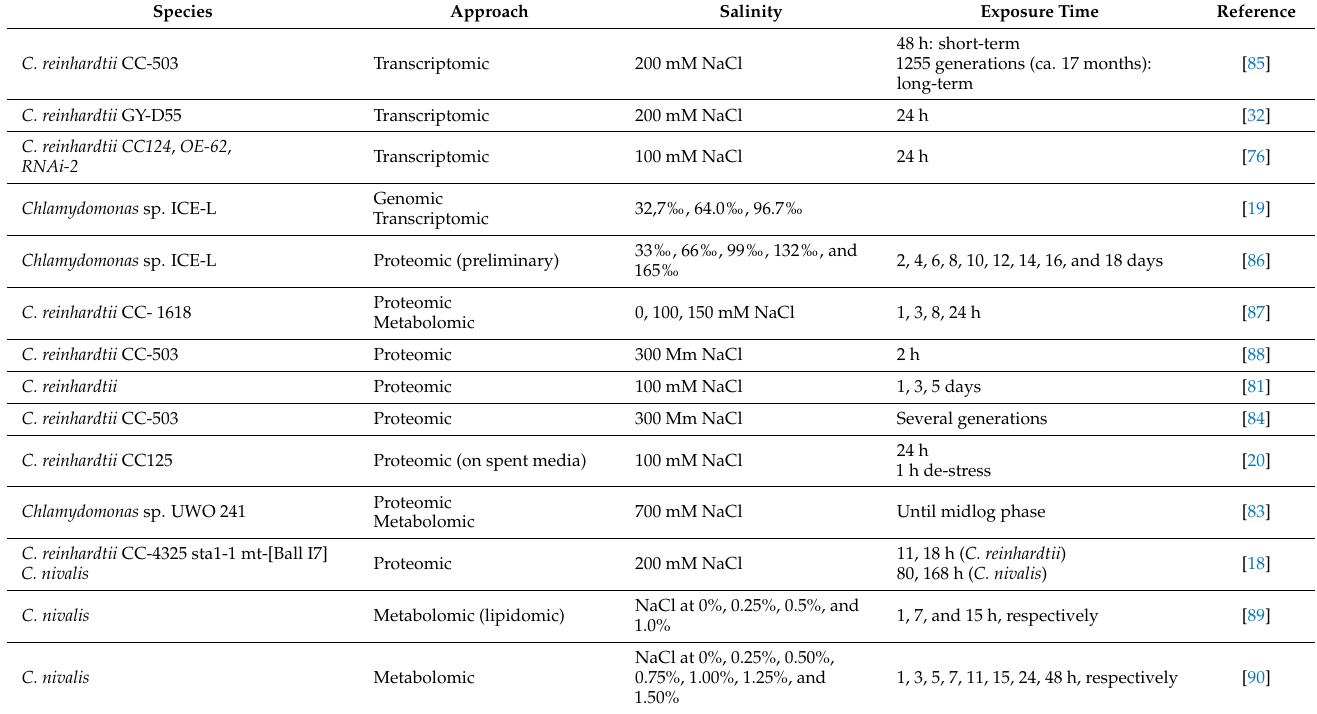
Table 3. This table summarizes omics studies performed on Chlamydomonas species exposed to salinity variations.